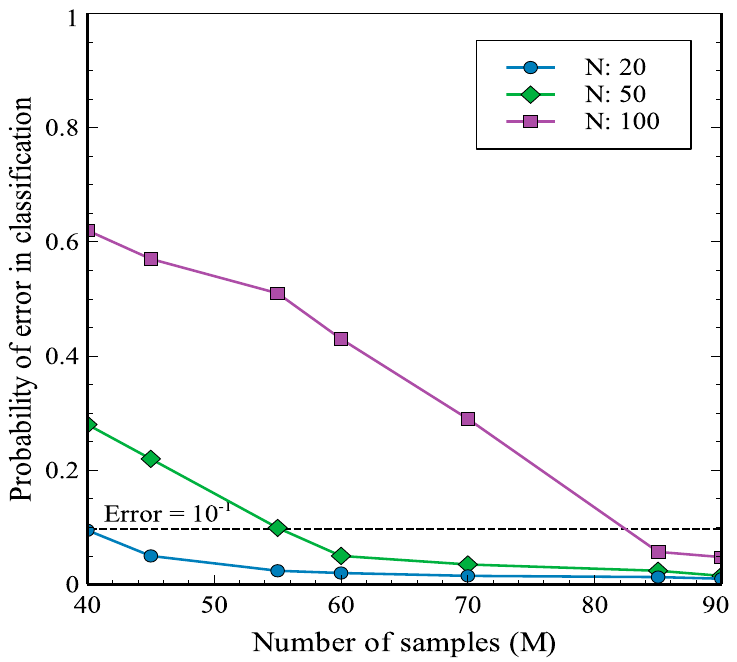
Figure 7. Probability of error in classification as a function of the number of measurements for the different number of classes (N = 20, 50 and 100).